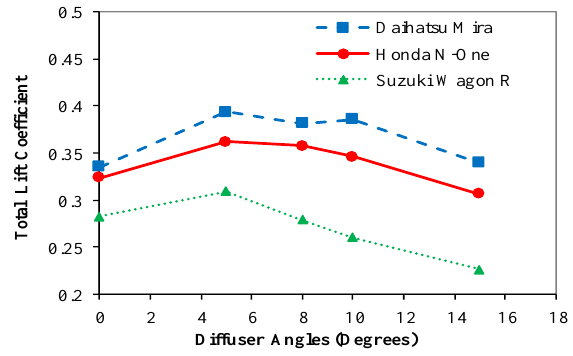
Fig. 21. Relation between lift coefficient and diffuser